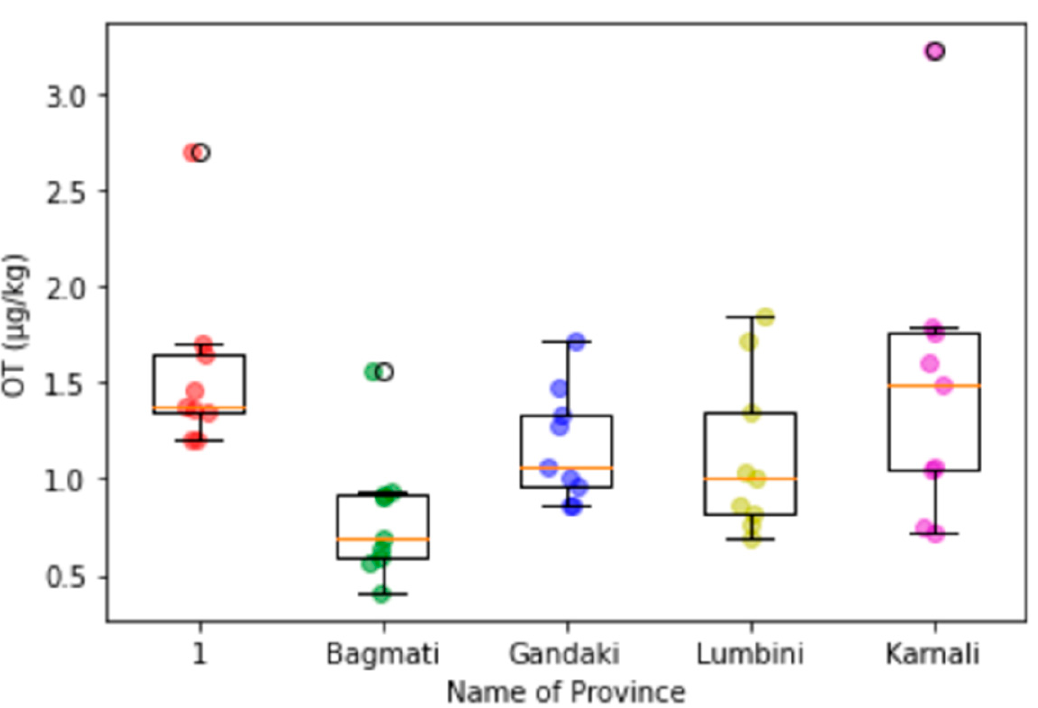
Figure A9. Contamination level of OT.